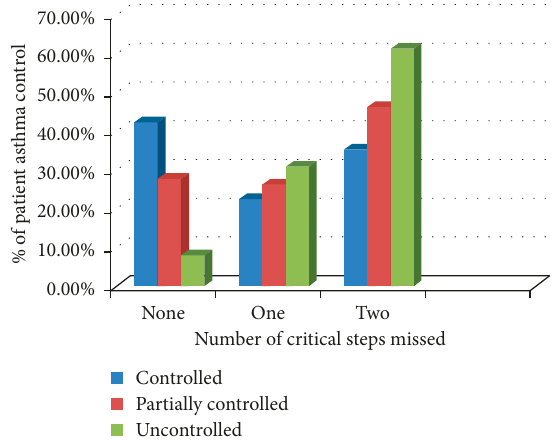
Figure 3: The relationship between asthma control status and number of critical steps missed, respiratory clinic, JUMC, Ethiopia, 2018.